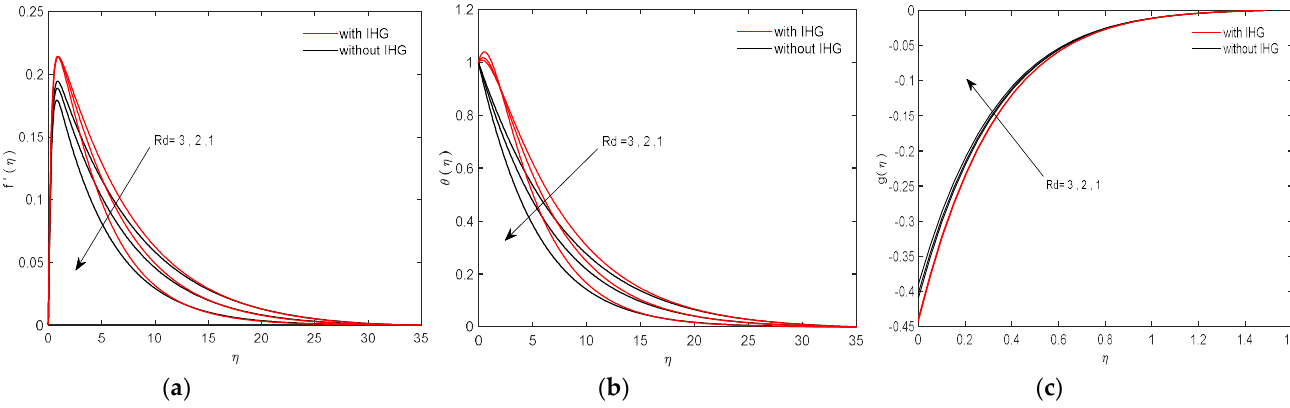
Figure 8. The effect of the radiation parameter Rd on the ( a ) velocity profile, ( b ) temperature profile and ( c ) angular velocity profile for R = 0.5, M = 2, λ = 0.5, c = 0, B = 0.2, Φ 1 = φ 2 = 0.05, Da = 10, f w = 0.5, n =